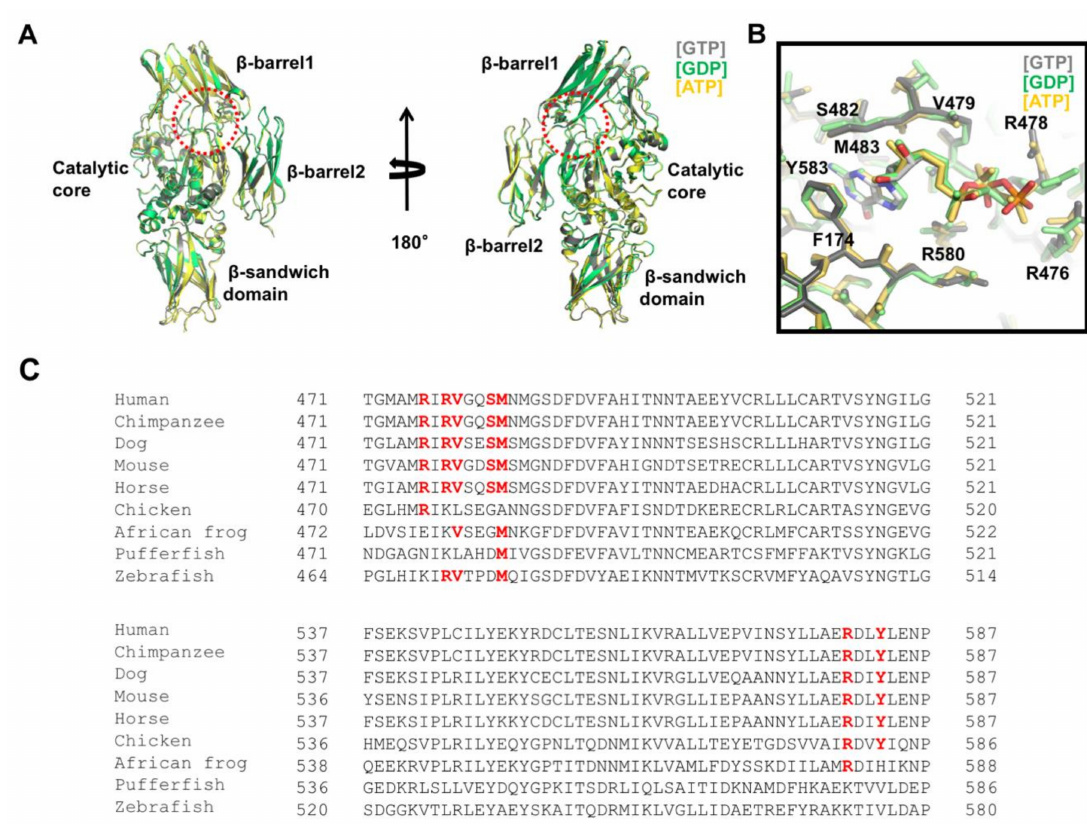
Figure 2. Structural analysis of the nucleotide-binding site on TGase2. ( A ) Structural comparison of TGase2 complexed with di ff erent nucleotides. Three di ff erent structures were superimposed and compared. The dotted red circle indicates the nucleotide-binding site located in between the catalytic core domain and the β -barrel1 domain. ( B ) Close-up view of the nucleotide-binding site on TGase2. Residues involved in the interaction with the nucleotides are shown. ( C ) Sequence comparison of TGase2 in various species. Residues important for binding with nucleotides are shown in red bold